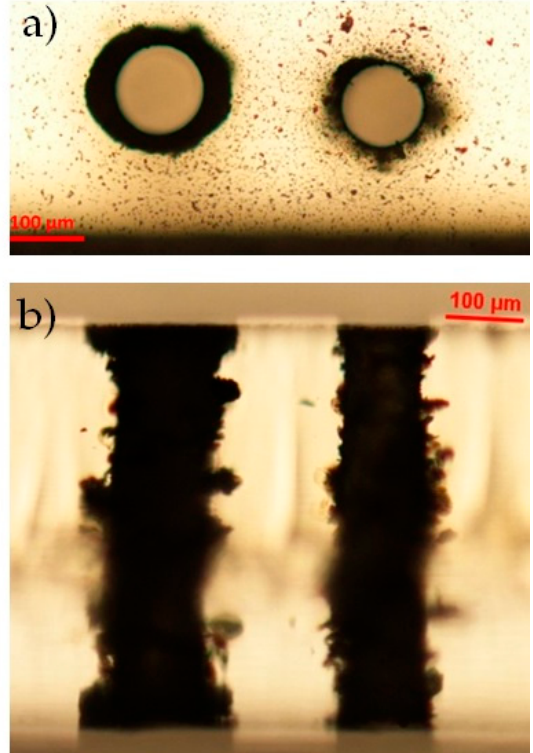
Figure 11. ( a ) Optical microscope images of holes (TOP view) in a 500 µ m thick PMMA microfab- ricated by sending the beam through one of the sample surfaces first and by repeating the drilling process by sending the beam through the other sample surface (bottom surface) after flipping the sample. The left hole is performed with pulse width of 1 ps and a pulse energy of 60 µ J, the right one with 18 ps and a pulse energy of 96 µ J; ( b ) optical microscope images of the lateral view of the through-holes shown in ( a